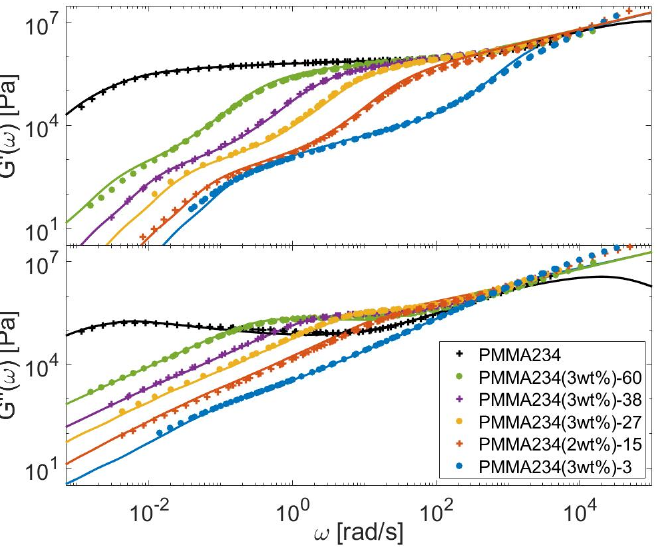
Figure 15. Comparison between predicted (continuous lines) and experimental (symbols) storage and loss moduli of the long PMMA chains in monodisperse state or diluted in various matrices (see Table